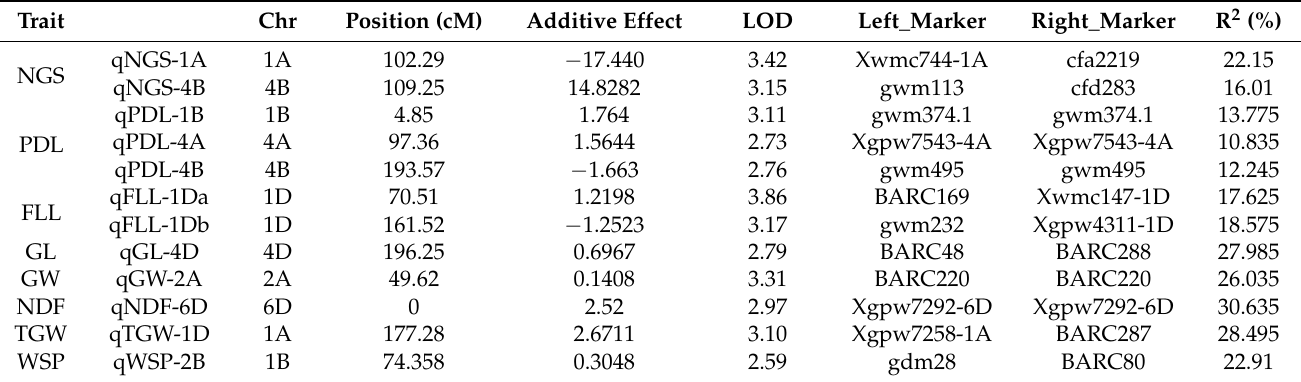
Table 3. QTLs identified using the F8 population derived from Gonbad × Zagrosin 2020.